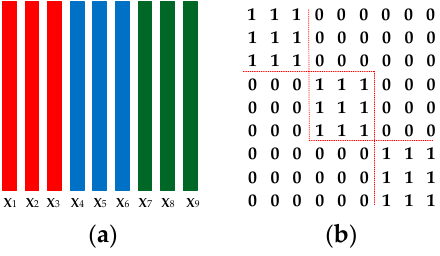
Figure 3. An illustration for the definition of matrix (cid:1787) . ( a ) 9 training samples from 3 classes with 3 samples per class; ( b ) The defined mask matrix (cid:1787) . If (cid:1864)(cid:4666)(cid:1824) (cid:3036) (cid:4667) = (cid:1864)(cid:3435)(cid:1824) (cid:3037) (cid:3439) , (cid:1787) (cid:3036),(cid:3037) = 1 , (cid:1787) (cid:3037),(cid:3036) = 1 , otherwise (cid:1787) (cid:3036),(cid:3037) = 0 , (cid:1787) (cid:3037),(cid:3036) = 0 . The diagonal-block elements of (cid:1787) are all ones, and the rest are zeros.